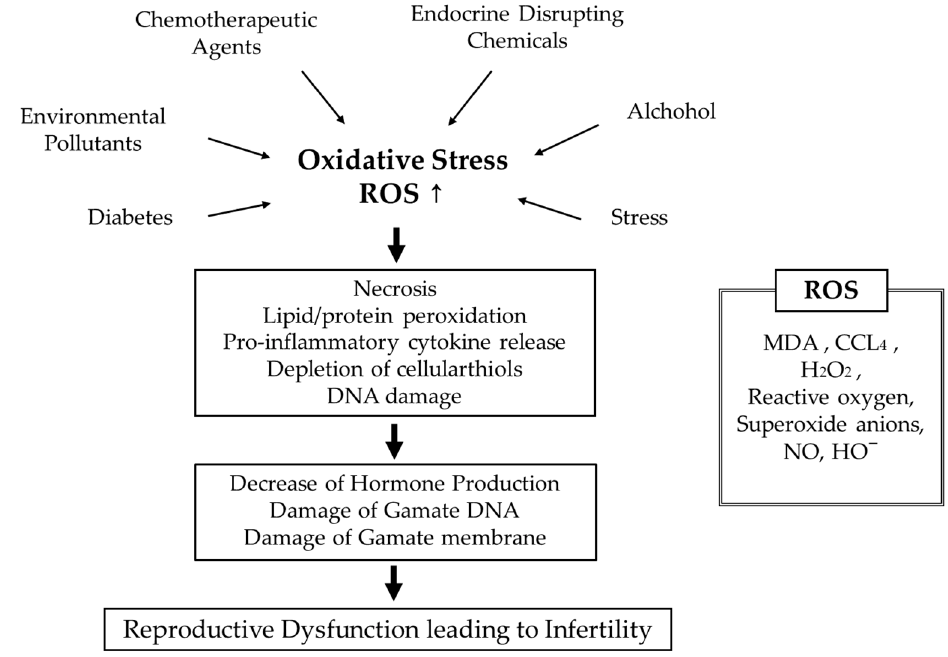
Figure 3. Reactive oxidative species (ROS) and infertility. ROS are induced from a variety of causes and consequently destroy the structure of lipid matrix in the membranes of spermatozoa and are associated with loss of motility and impairment of spermatogenesis.